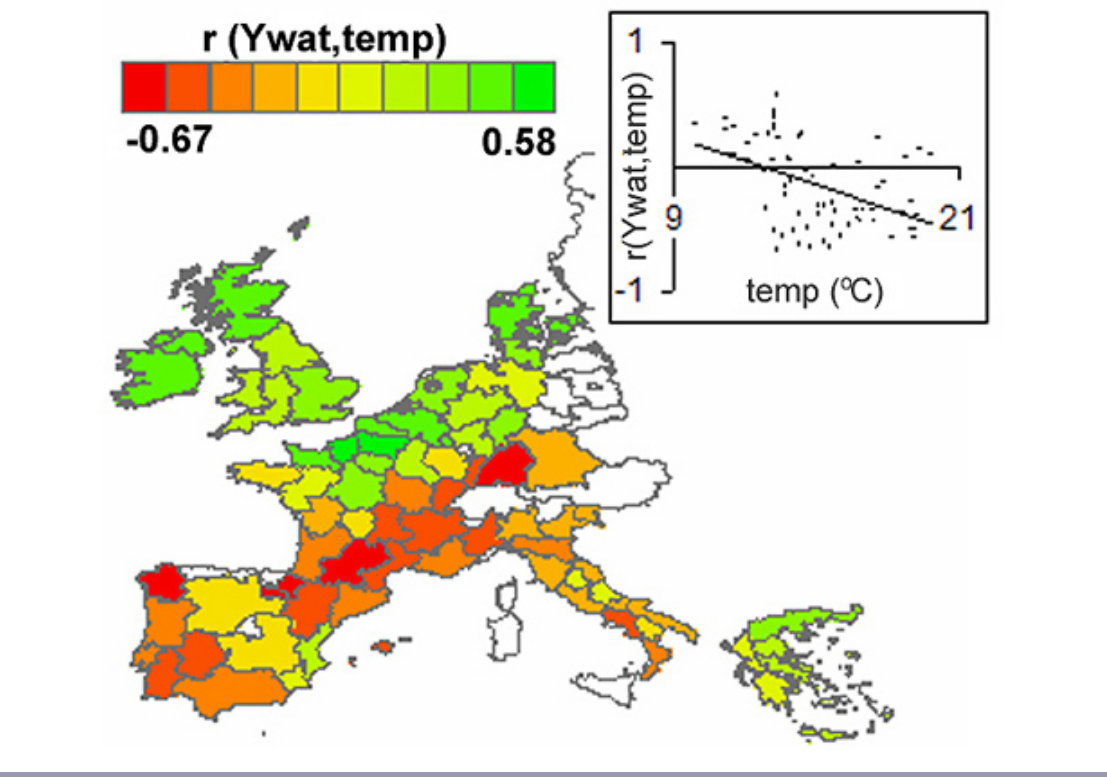
Fig. 4. Spatial distribution of the correlation between inter-annual variability in temperature and water- limited yields [r(Ywat,temp)], and relationships to average temperature (temp, °C) from 1990–2003. In contrast to what is observed in Fig. 2, the crop model projects negative impacts of higher temperatures, especially in regions with already higher